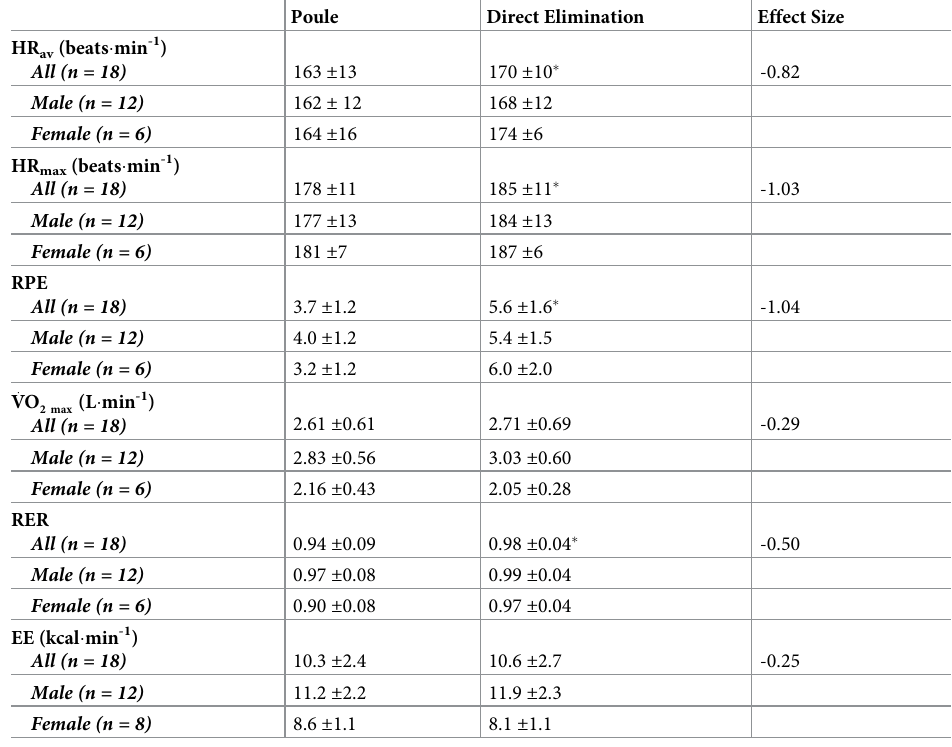
Table 3. Heart rate average (HR av ), maximum heart rate (HR max ), ratings of perceived exertion (RPE), maximum oxygen uptake ( V _ O ), respiratory exchange ratio (RER) and energy expenditure ( E _ E ) for all 2 max